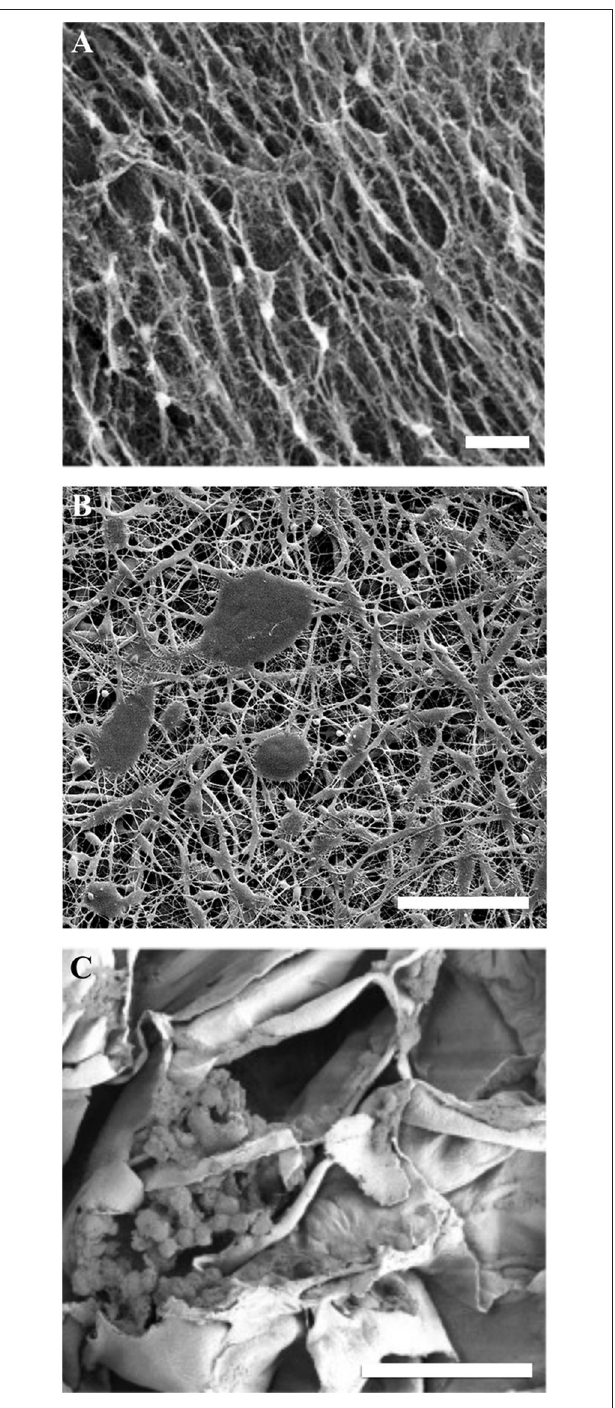
FIGURE 3 | SEM images of cellulose biomaterials. (A) NIH 3T3 cells cultured on a bacterial cellulose film, scale = 10 µ m (Fu et al., 2013). Copyright 2013. Reproduced with permission from Elsevier Inc. (B) Schwann cells cultured on a synthetic electrospun cellulose matrix, scale = 100 µ m (Naseri-Nosar et al., 2017). Copyright 2017. Reproduced with permission from Elsevier Inc. (C) C2C12 cells cultured on decellularized apple cellulose scaffolds, scale = 50 µ m. (Modulevsky et al., 2014) Copyright 2014. Reproduced with permission from